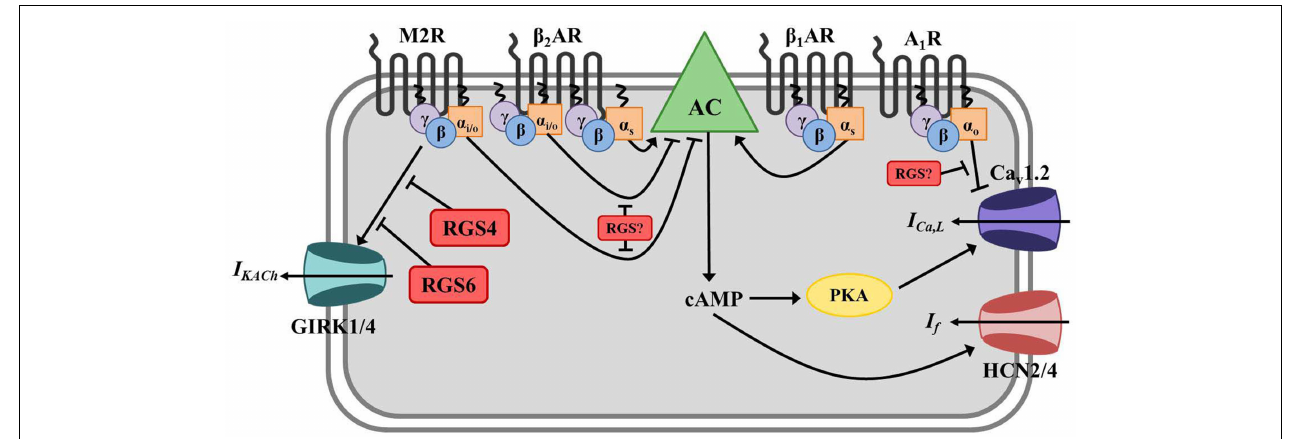
FIGURE 2 | Regulator of G protein signaling-mediated regulation of directly induce G protein-coupled inwardly rectifying potassium channel cardiac automaticity in the sinoatrial node (SAN). In the SAN, G s -coupled (GIRK) current ( I KACh ) via G βγ resulting in membrane hyperpolarization and β β β inhibition of nodal cell firing. β 2 ARs can also couple to G α i/o in these cells and 1 - or 2 -adrenergic receptors ( 1/2 AR) stimulate adenylate cyclase block AC-mediated cAMP production. Adenosine A 1 receptors (A 1 R) also have (AC)-mediated production of the second messenger cyclic AMP (cAMP), activation of cAMP-dependent protein kinase (PKA), activation of a negative chronotropic effect in the SAN via G α o -dependent inhibition of I Ca,L , hyperpolarization-activated cyclic nucleotide-gated cation (HCN) channels and though the exact mechanism whereby this occurs remains unclear. RGS4 and L-type calcium channels (primarily Ca v 1.2), and induction of the pacemaker RGS6 both function to inactivate G α i/o activated by M2Rs and block current ( I f ) and calcium current ( I Ca,L ).The net effect is membrane subsequent acetylcholine-activated GIRK current ( I KACh ) in SAN.The specific depolarization and increased nodal cell excitation. AC is inhibited by G α i/o -coupled muscarinic M2 receptors (M2R), and activated M2Rs can also